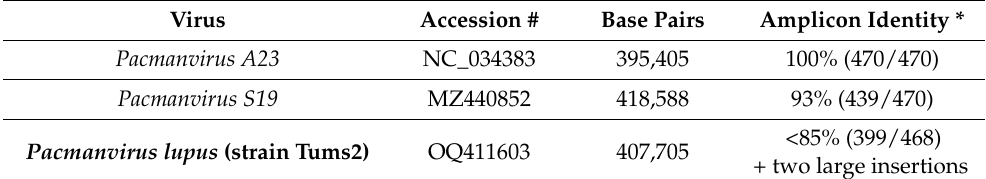
Table 6. PCR Identification of Pacmanvirus lupus (strain Tums2) as a new member of genus